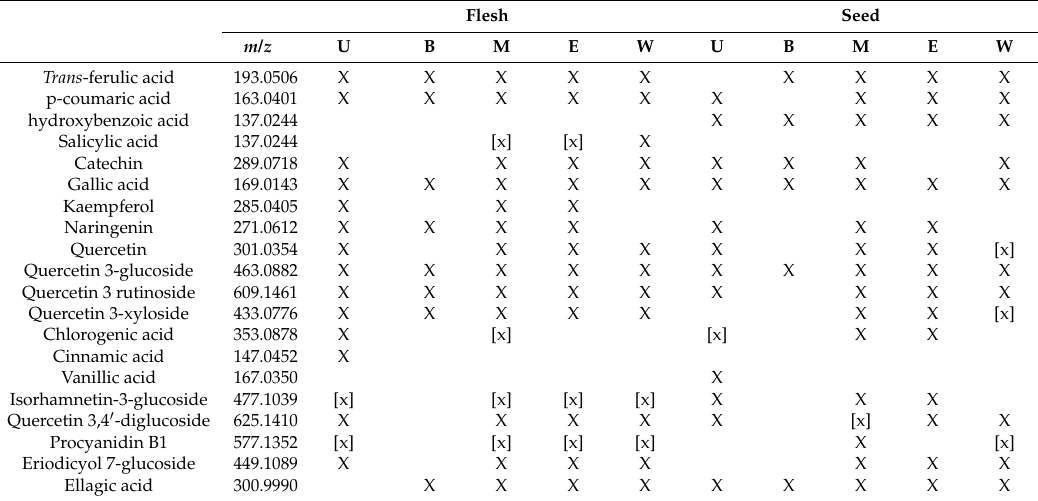
Table 3. Compounds found in green plum flesh and seed extracts using ultra high pressure liquid